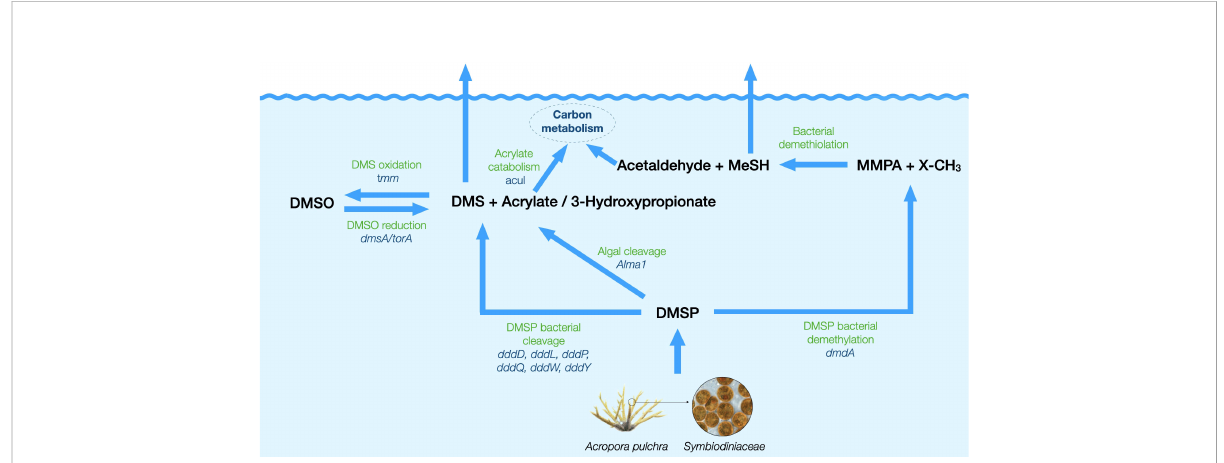
FIGURE 3 Schematic diagram of the putative pathways for the production and cycling of DMSP and derivatives around the studied A. pulchra colony, with the involved genes quanti fi ed in this study. DMSP is produced by the coral, the Symbiodiniaceae , and heterotrophic bacteria, and the target genes were DSYB for eukaryotes and dsyB for prokaryotes. DMSP is degraded into DMS and acrylate by its eukaryotic producers through the action of the Alma1 gene, and also undergoes bacterial catabolism via multiple pathways: (i) bacterial demethylation into methylmercaptopropionate (MMPA), encoded by the gene dmdA , followed by demethiolation to methanethiol and acetaldehyde; (ii) bacterial cleavage into DMS and acrylate, targeted by the genes dddP, dddL, dddQ, dddW , and dddY ; (iii) bacterial cleavage into DMS and 3- hydroxypropionate, encoded by the gene dddD . DMS oxidation to DMSO is encoded by tmm , and the reverse reduction is encoded by the DMSO/TMAO reductase gene ( dmsA/torA ). Acrylate is catabolized into the central carbon cycle, and one of the genes involved is acuI . Description and references of all these genes are given in Table